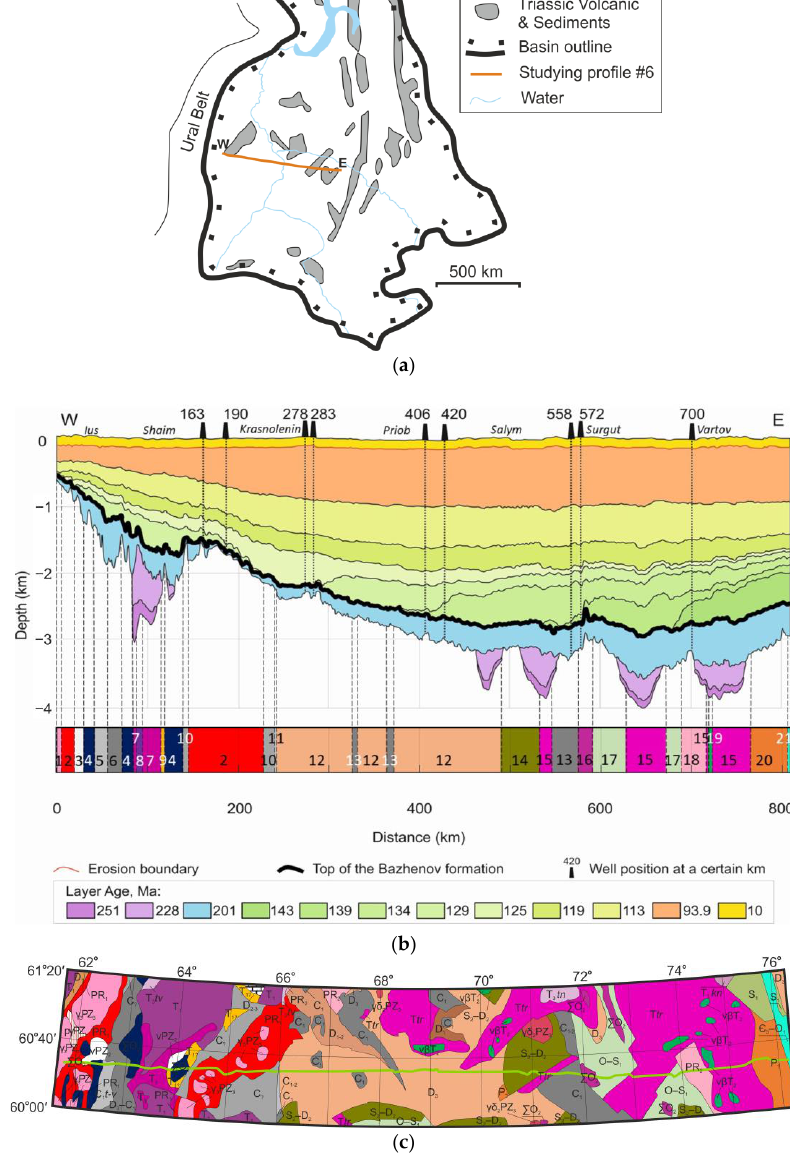
Figure 1. ( a ) Schematic map of Western Siberia with the location of the studied profile (modified after [39]); ( b ) present-day simplified stratigraphy of the regional profile 6 linked with the lateral limits of the heterogeneous basement blocks in Model 2 (modified after [6]). The number of blocks and colours correspond to the material properties presented in Table 1. The names of petroleum regions are presented in italics. ( c ) The geological map of the heterogeneous basement (modified after [44–46] ) ; the geological description used in the study blocks is presented in Table 1. The green curve highlights the profile location.